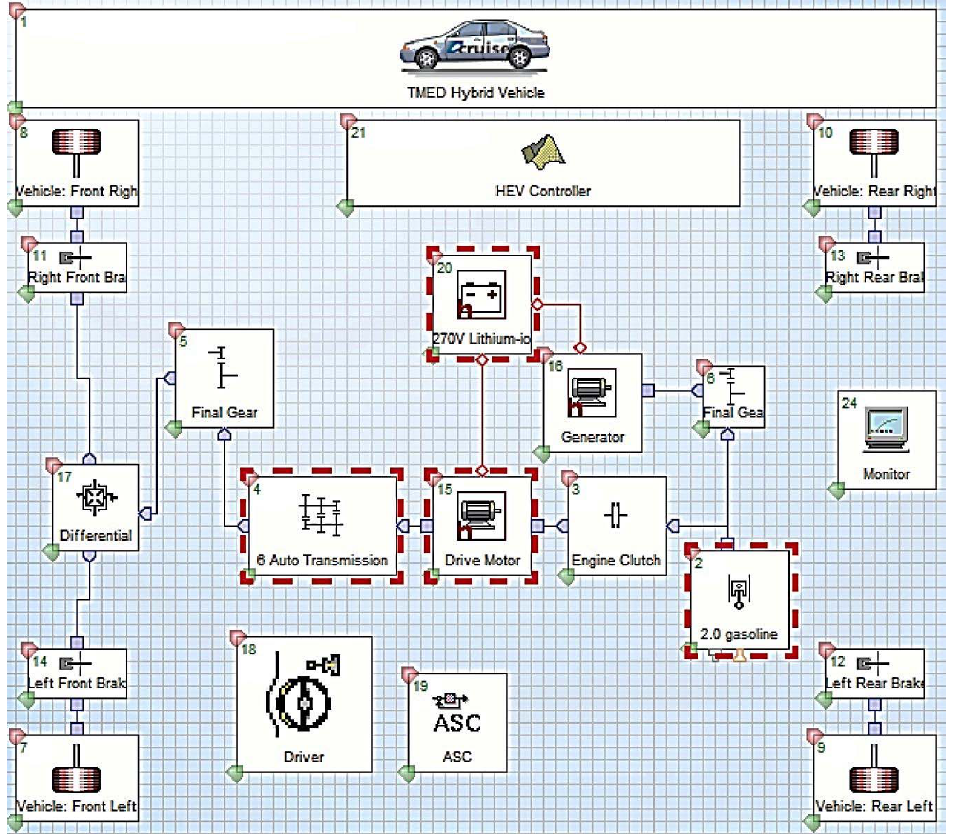
Figure 5. Full numerical model of TMED-type HEV developed using CRUISE. Table 2. Main elements of a hybrid vehicle model under CRUISE.